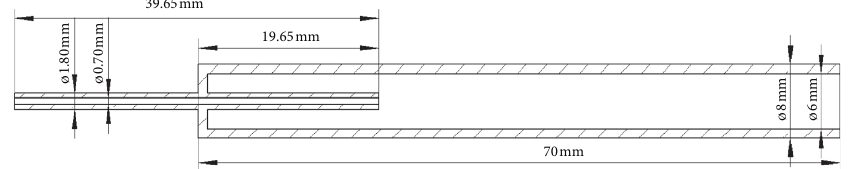
Figure 2: Transition pipe before optimization.